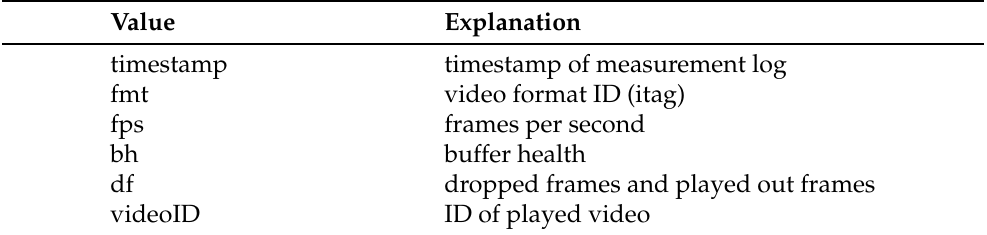
Table 3. Application data overview.